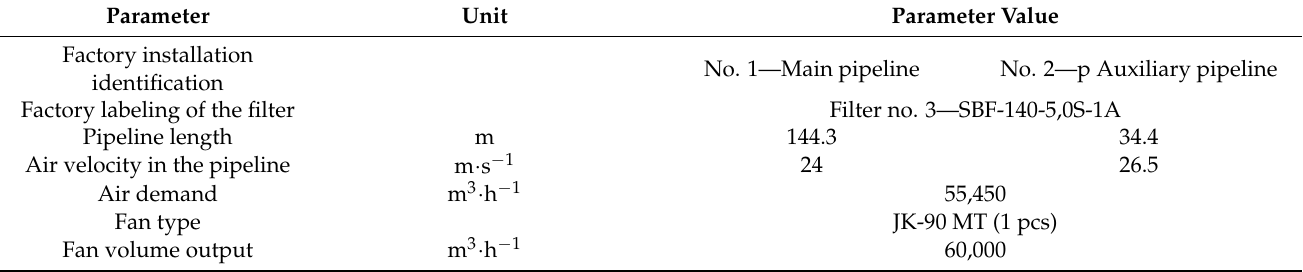
Table 1. Basic technical parameters of the dust-extraction installations.